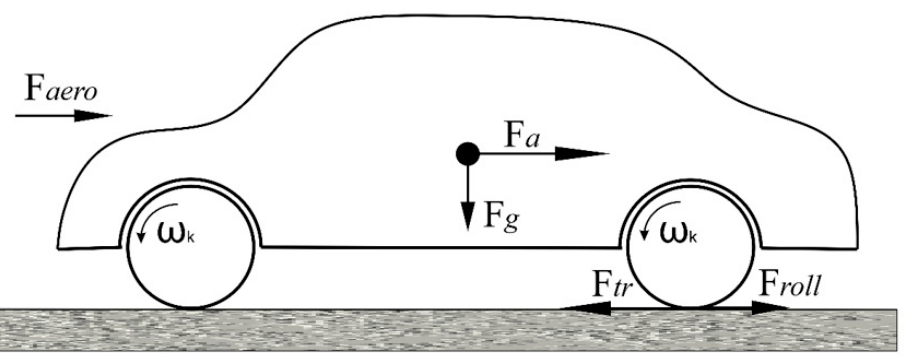
Figure 1. Vehicle dynamic model.